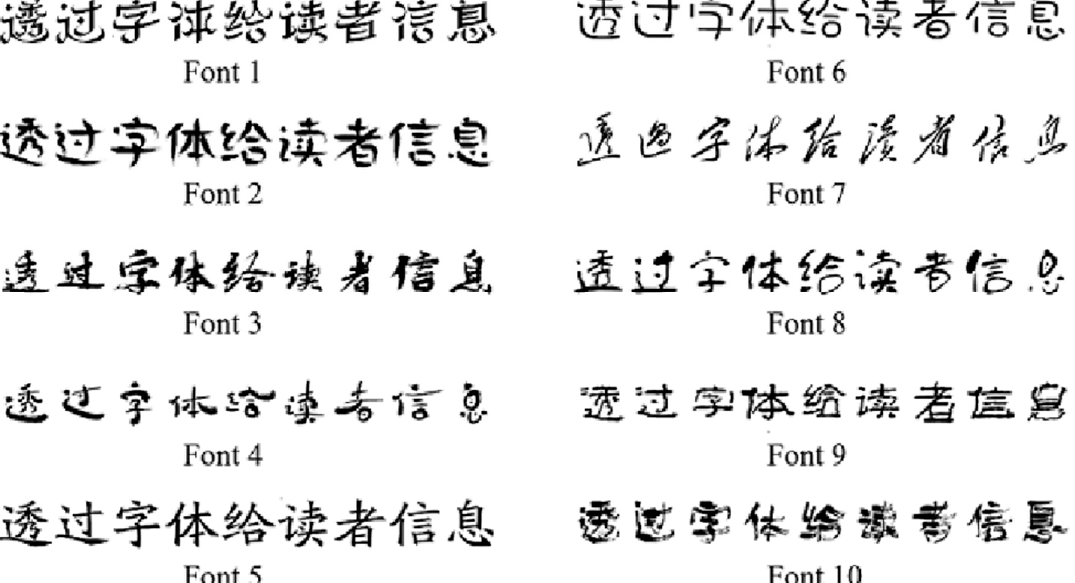
Figure 1. Options for questionnaire determined by five calligraphy experts and 25 common respondents.